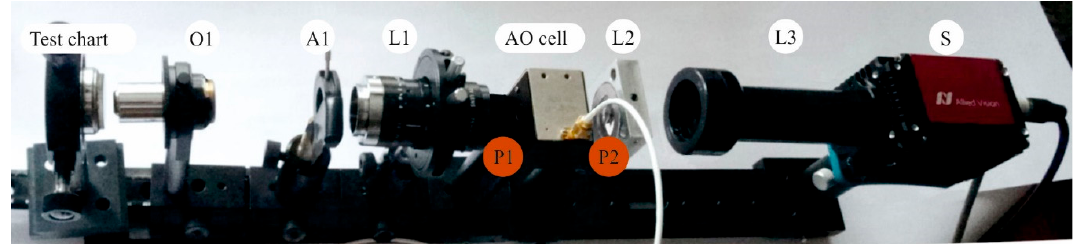
Figure 6. Experimental system. P1, P2—positions for polarizers in reference experimental scheme. (Element designations are presented in text.).